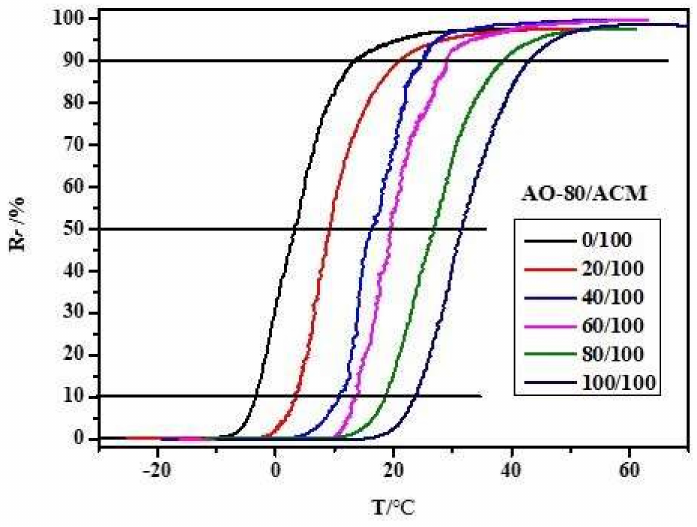
Figure 9. R r –T curves of AO-80/ACM rubber